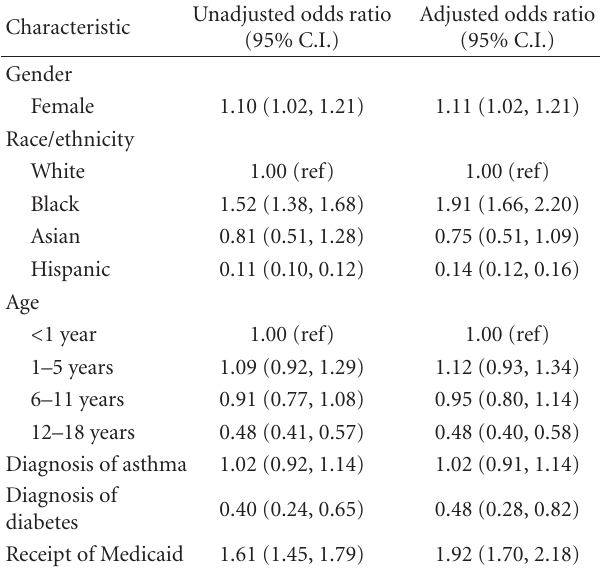
Table 2: Unadjusted and adjusted a odds ratios for sociodemo- graphic and clinical characteristics comparing network versus nonnetwork community